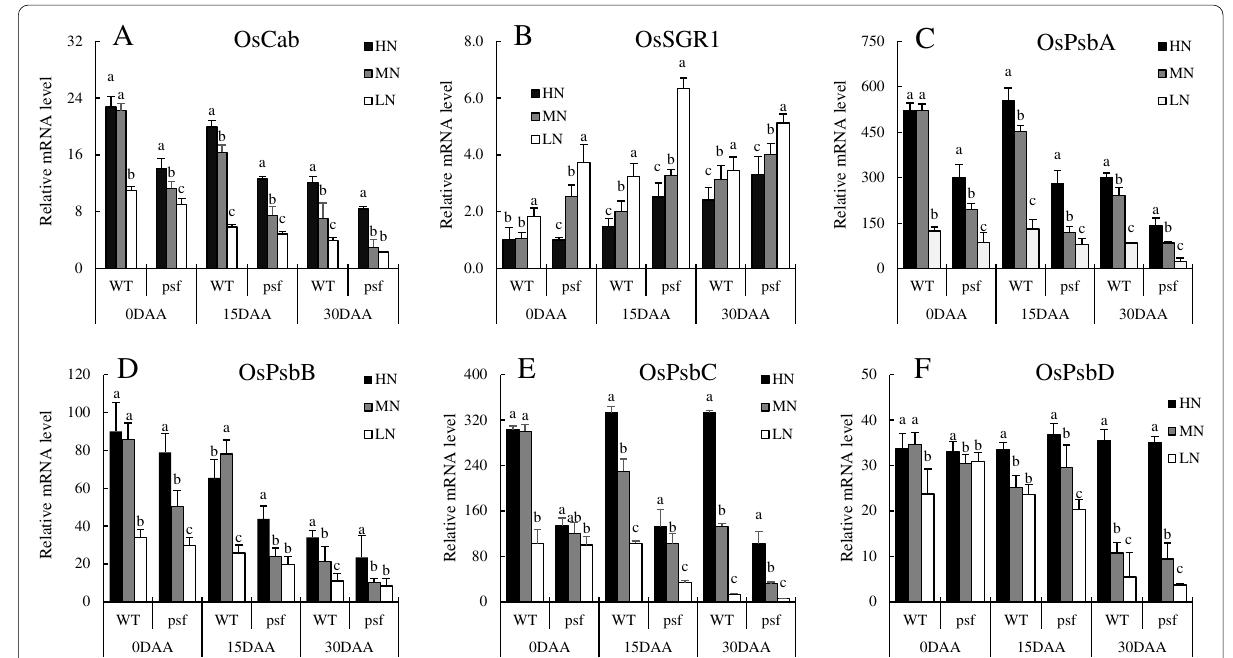
Fig. 2 Differential expression level of A gene encoding light-harvesting chlorophyll a/b binding protein (Cab), B Chl degradation associated gene (OsSGR), C photosystem II binding proteins A ( OsPsbA ), D ( OsPsbB ), E ( OsPsbC ), and F ( OsPsbD ) in the flag leaves of wildtype and psf mutant under different N levels during leaf senescence process. Relative gene expression levels were normalized to those of actin at corresponding time points. Data are presented as means SD (n 3). Different letters indicate significant differences at P < 0.05 (LSD) between nitrogen treatments, ± =